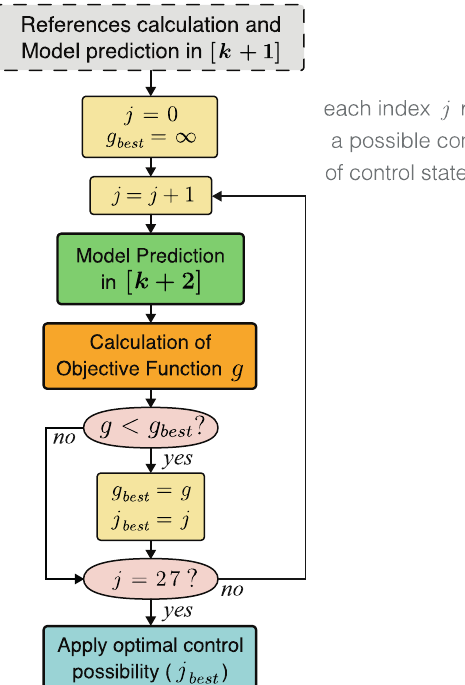
Figure 6. Flowchart regarding a cost function